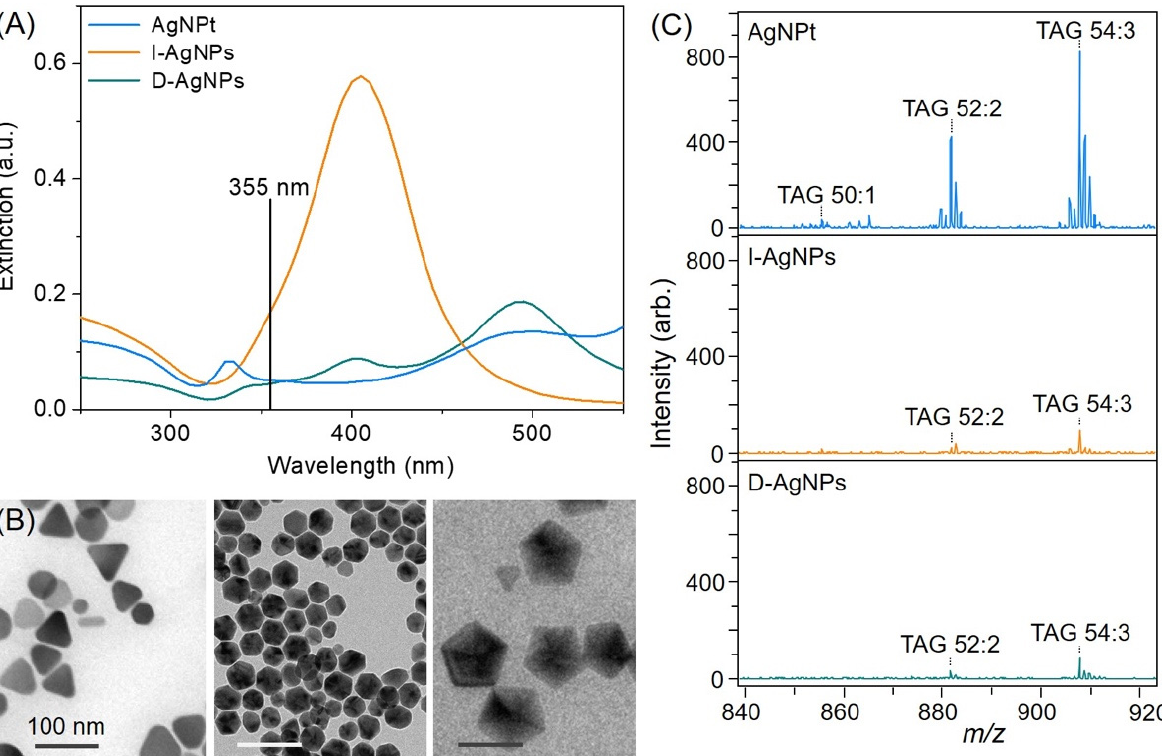
Figure 1. ( A ) Ultraviolet-visible absorption spectrum and ( B ) TEM images of AgNPts, I-AgNPs, and D-AgNPs. ( C ) Mass spectra of TAG profiles obtained using various AgNPs.